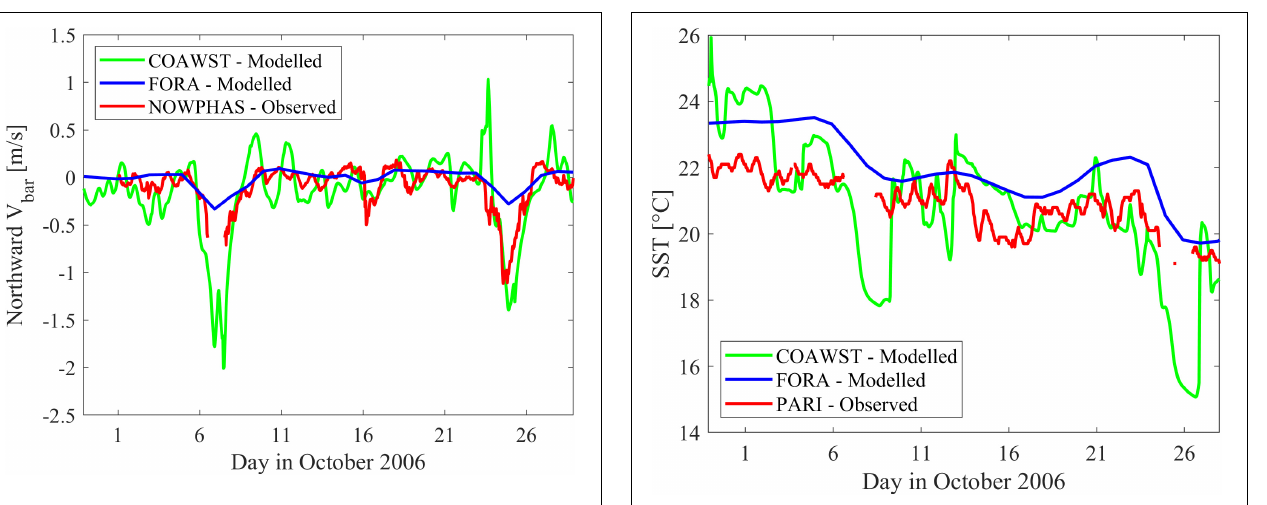
values of 0.28, 0.43, and 0.27, respectively. The modeled results